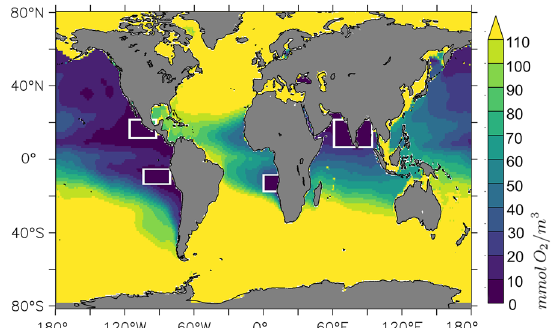
Figure 1. Illustration of regions where low, or even nil oxygen concentrations have been measured in the water column. The colours denote the lowest concentrations found in local water columns as archived by the World − 3 Ocean Atlas 2005 35 in units mmolO 2 m . The white boxes mark the cores of notorious contemporary oxygen minimum zones (OMZs), as referred to in Table 1. This figure was created with PyFerret v7.5 (https:// ferret. pmel. noaa. gov/ Ferret/ docum entat ion/ pyfer